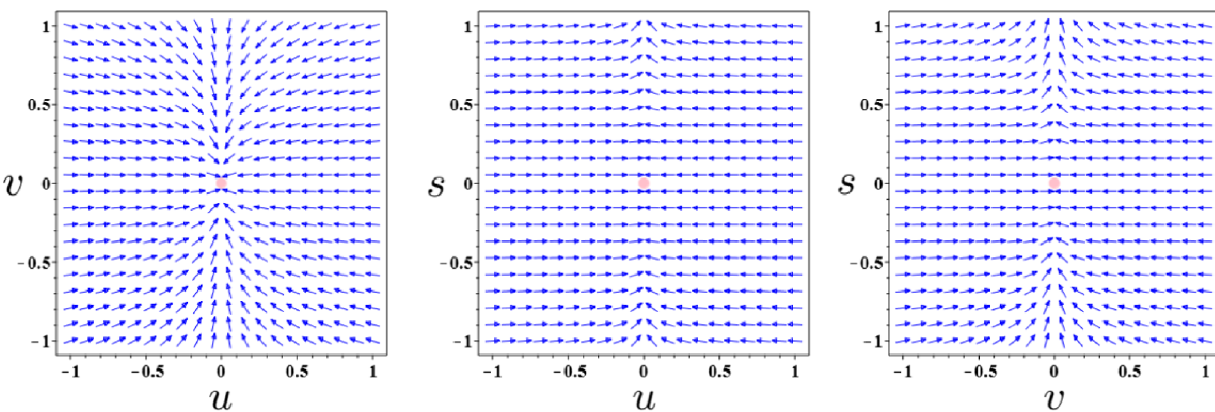
Fig. 6 This figure illustrates three different Poincaré sections of phase space of the system (158)–(160). In plotting these diagrams, we have assumed κ 2 = 1, A = 1, B = − 9, m 1 = 1, and α = 1. The pink points show the critical points